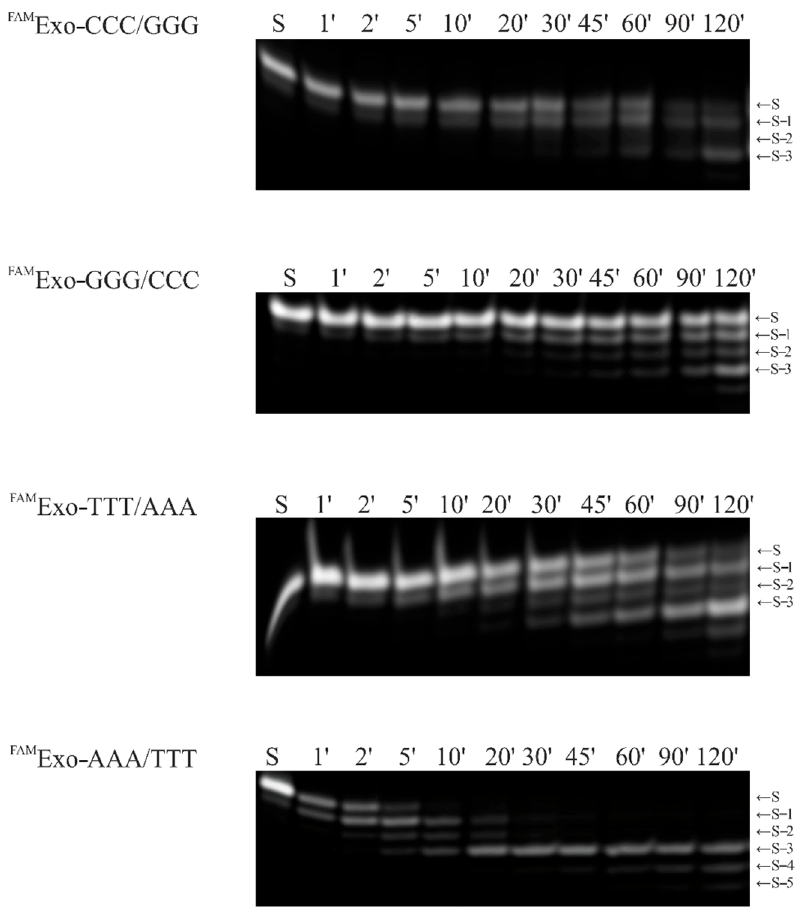
Figure 3. Accumulation of products of the 3 ′ –5 ′ –exonuclease reaction during the interaction of Apn2 with DNA substrates ([DNA] = [Apn2] = 1 μ M, T = 37 °C).